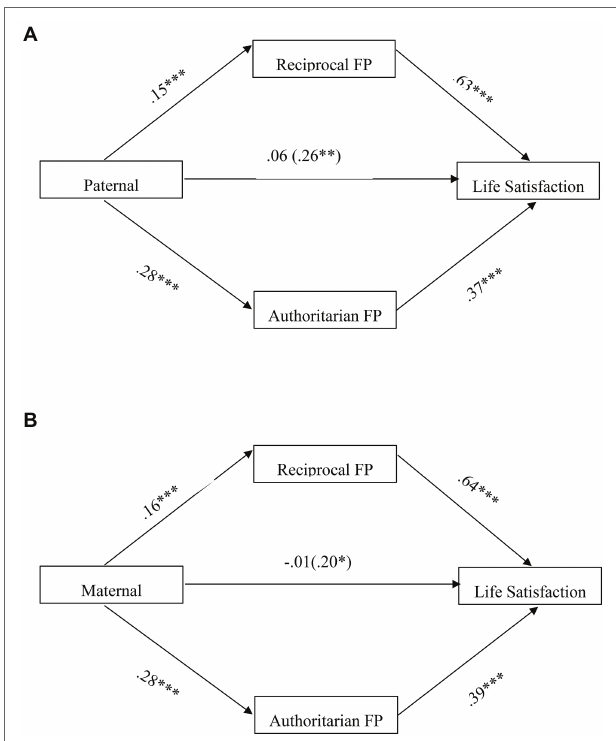
FIGURE 1 | (A) Mediation model showing the effect of paternal parenting and filial piety on life satisfaction. The values shown are unstandardized coefficients. The total effect of paternal parenting was shown in parenthesis. *** p < 0.001; ** p < 0.01. (B) Mediation model showing the effect of maternal parenting and filial piety on life satisfaction. The values shown are unstandardized coefficients. The total effect of maternal parenting was shown in parenthesis. *** p < 0.001.